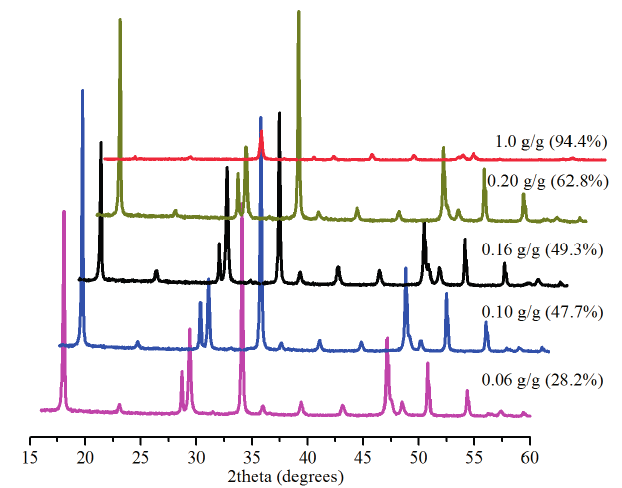
Figure 8. XRD patterns and corresponding conversions (in brackets) for samples produced with 10 mL water and various amounts of Bmim[Br] in 5